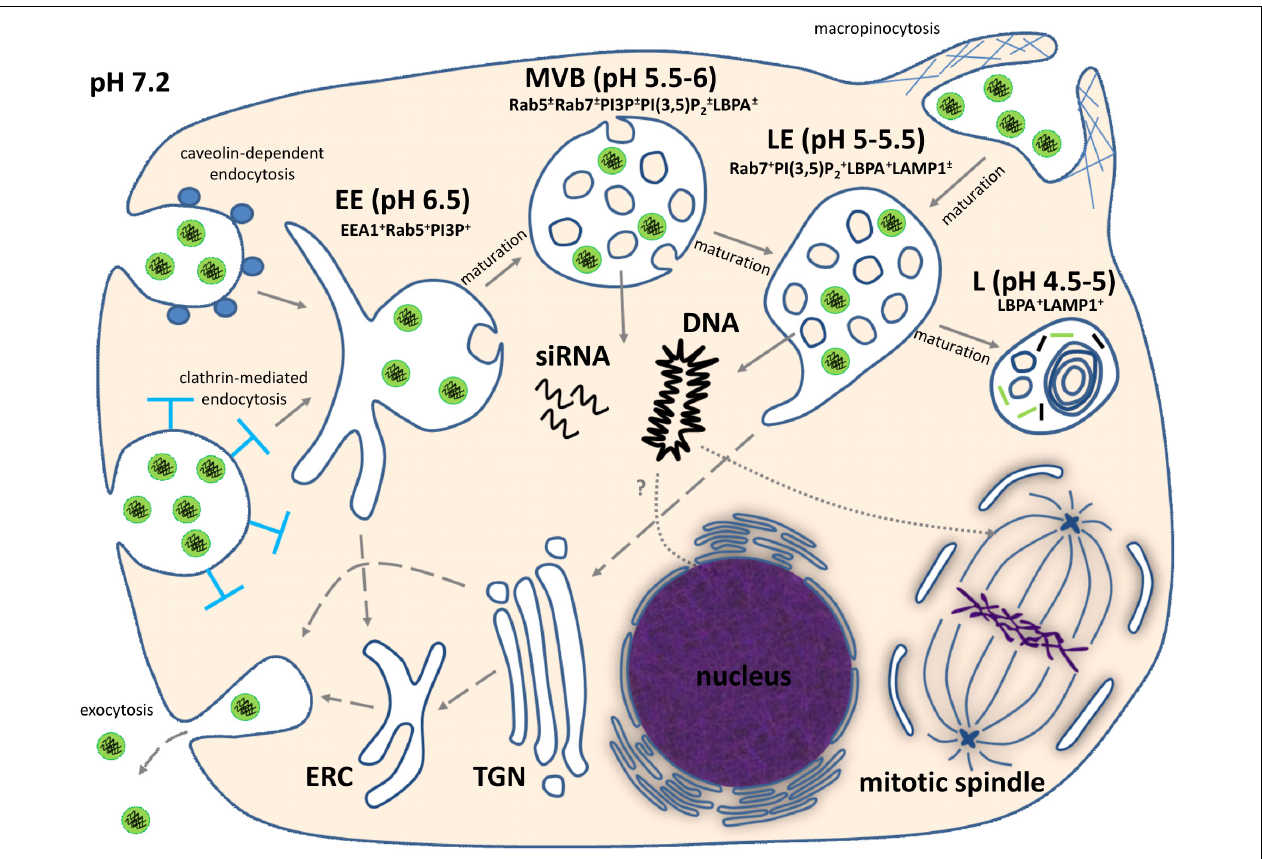
FIGURE 1 | Intracellular trafficking of non-viral nucleic acid nanoformulations. Comments can be found in the text. EE, early endosome; MVB, multivesicular body; LE, late endosome; L, lysosome; ERC, endocytic recycling compartment; TGN, trans -Golgi network; EEA1, early endosome antigen 1; PI3P, phosphatidylinositol 3-phosphate; PI(3,5)P 2 , phosphatidylinositol (3,5)- bis phosphate; LBPA, lyso bis phosphatidic acid; LAMP1, lysosomal-associated membrane protein 1. “+” and “ ± ” mean high and moderate levels of abundance,